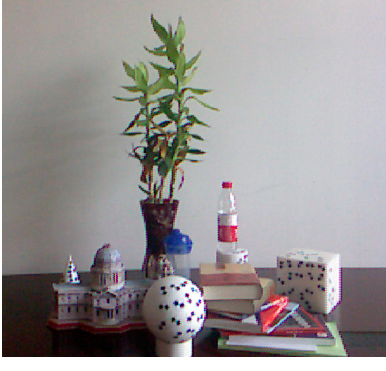
Figure 10. Complex scene.